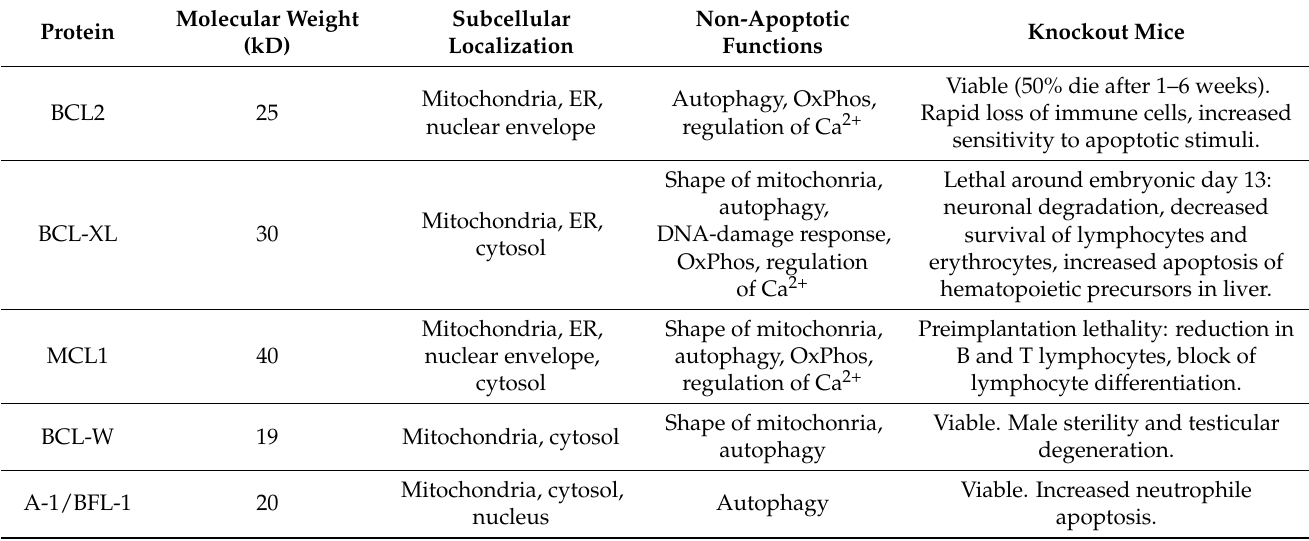
Table 1. Localization, non-apoptotic functions, and knockout phenotypes of anti-apoptotic BCL2 proteins. Molecular Protein